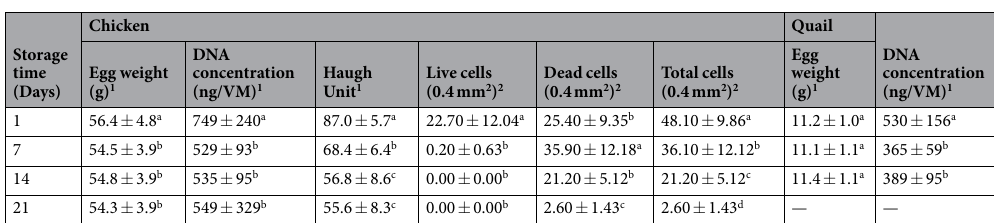
Table 1. Results of the egg quality measurements. 1 Thiry eggs were detected in each group; 2 The eggs were detected in each group. Note that the 10 eggs used for LSCM were not derived from the 30 eggs used for DNA concentration and Haugh Unit determination. Means ± SD: the same column without a common superscript differ significantly at P <